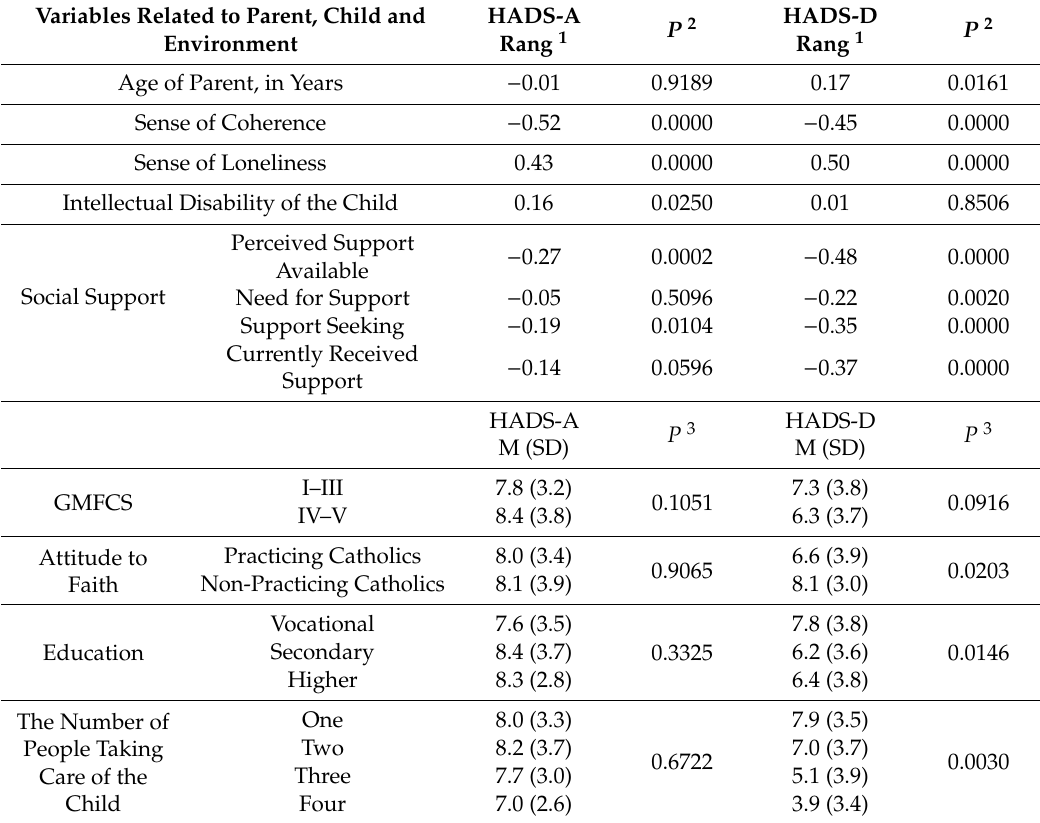
Table 8. Analysis of the relationship between factors linked to the parents of children with Cerebral Palsy (CP) and level of anxiety and depression in the study